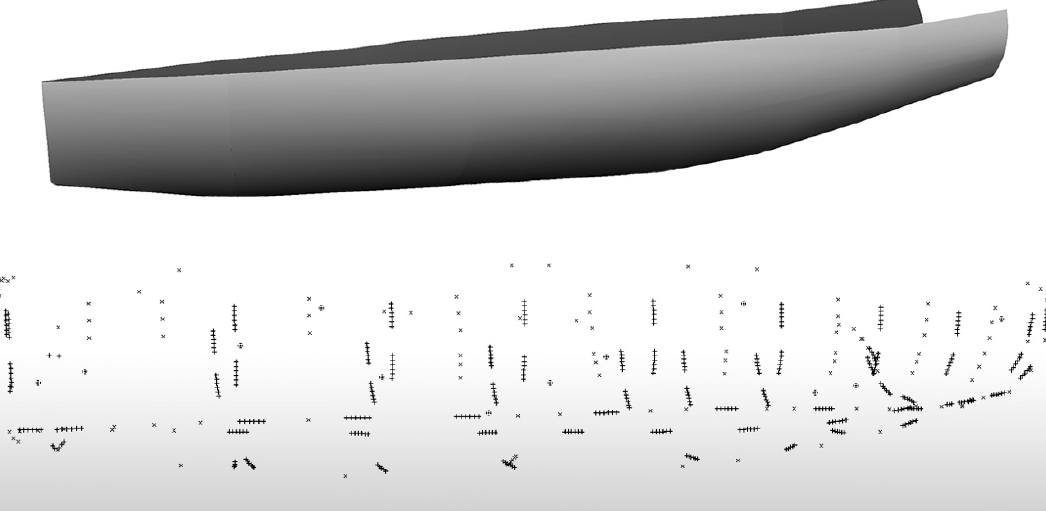
Figure 7. Down - resulting 524 points of processing by convergence case of digital CRP; up—the final Non–Uniform Rational Bezier Spline (NURBS) model.